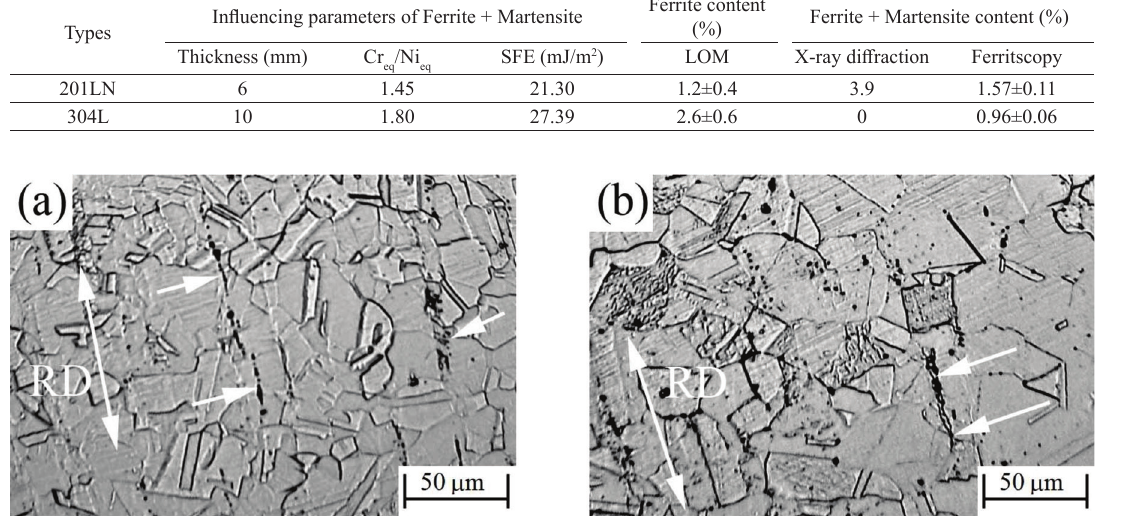
Table 3. Influencing parameters and phase quantification of delta ferrite and martensite.